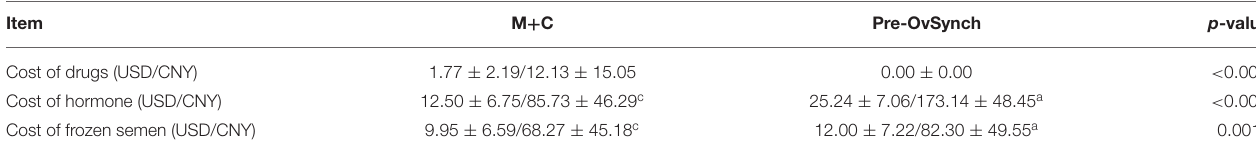
Different superscripts between columns indicate significant difference, p <